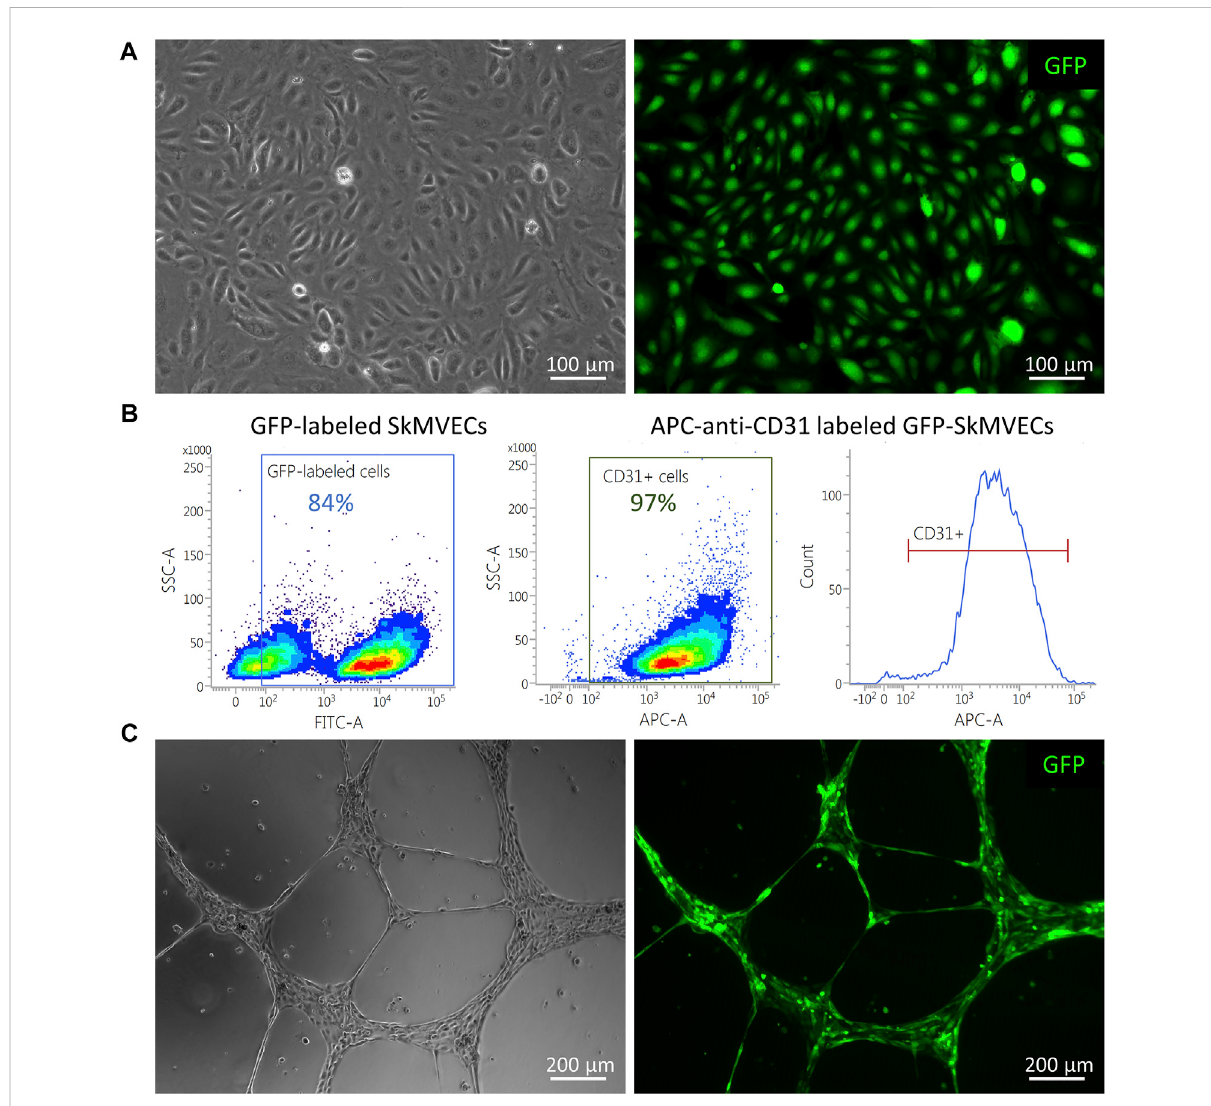
FIGURE 8 GFP-expressing SkMVECs. (A) Microscopic image of cobblestone-shaped isolated SkMVECs (left image) showing GFP expression post viral vector transduction (green, right image). (B) Flow cytometry analysis result showing out of 84% GFP-expressing cells, 97% are positive for the endothelialcellmarkerCD31. (C) TubeformationassayongrowthfactorreducedMatrigelshowingformationofendothelialnetworks(leftimage)by isolated GFP-expressing SkMVECs (green, right